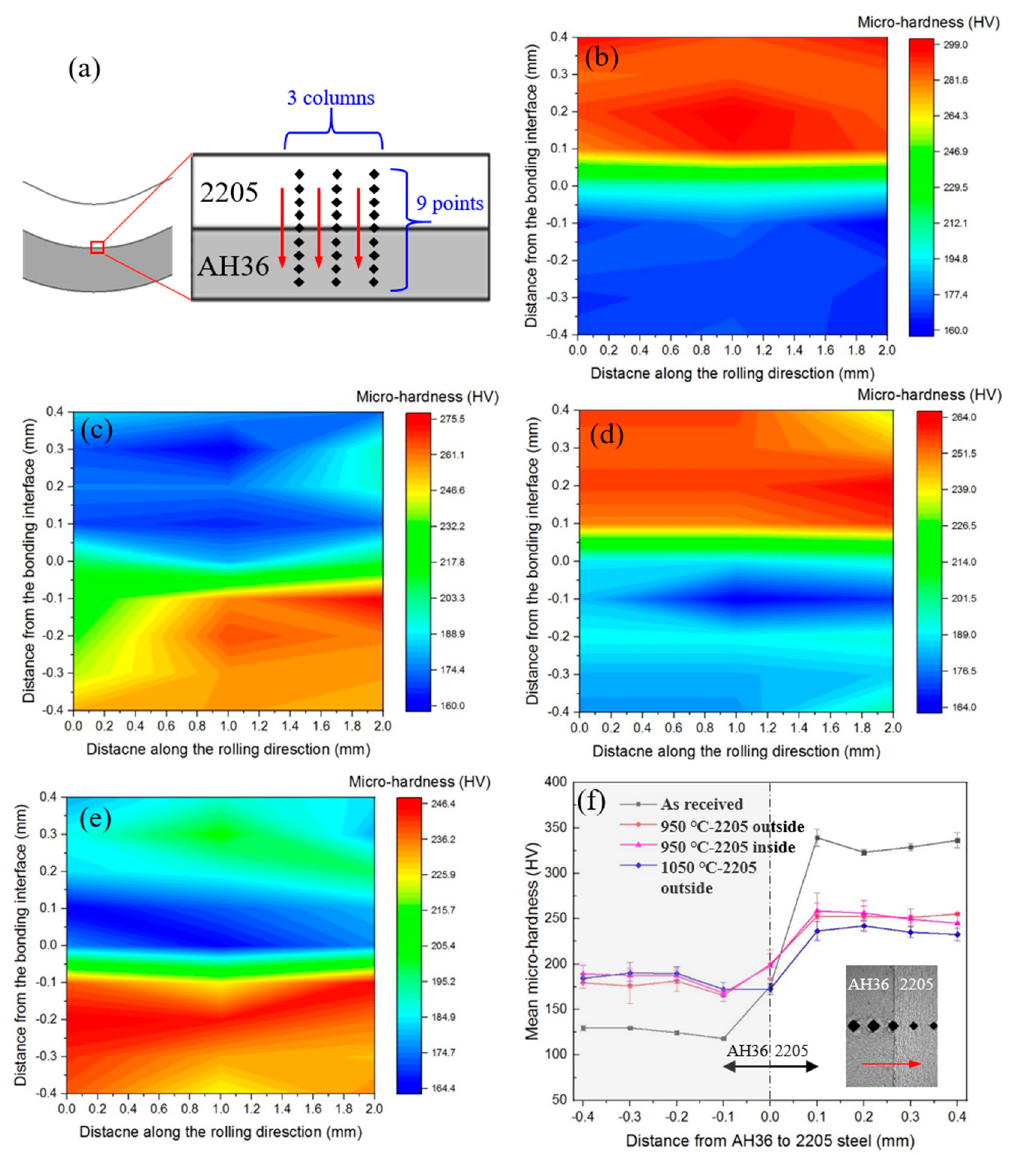
Figure 11. ( a ) Micro-hardness measurement scheme, ( b – e ) micro-hardness cartography maps of the as-received specimen, and specimens after hot bending at 950 °C with the outside 2205 layer, 950 °C with the inside 2205 layer and 1050 °C with the outside 2205 layer, and ( f ) comparison of the mean micro-hardness under different states.